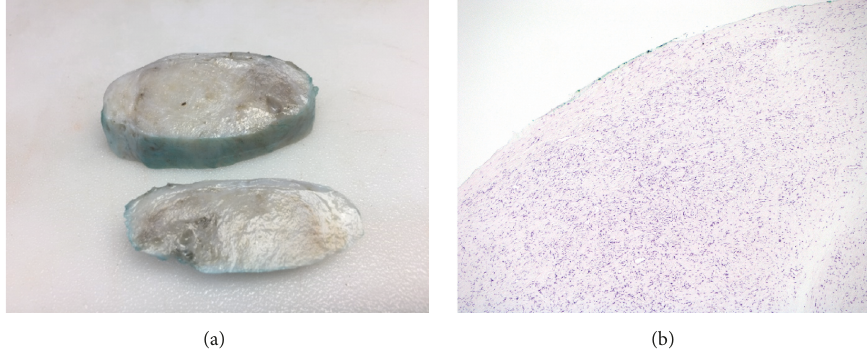
Figure 2: (a) Gross photograph of the tumor. The tumor is well-circumscribed with a thin fibrous membrane. (b) The tumor at low magnification, demonstrating the tumor border (H&E, x40). Table 2: Comparison of the immunohistochemical profile of classical cellular angiofibroma, SFT, and our patient’s spermatic cord tumor. Immunostain Cellular Angiofibroma SFT Patient’s